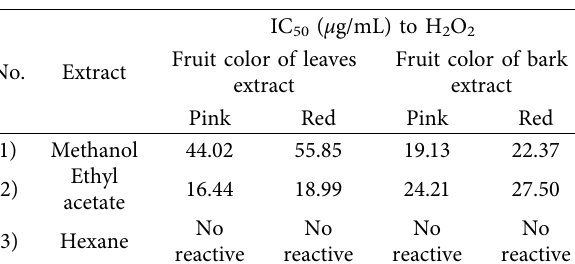
Table 4: Antioxidant activities 50 (IC stem bark extracts to hydrogen